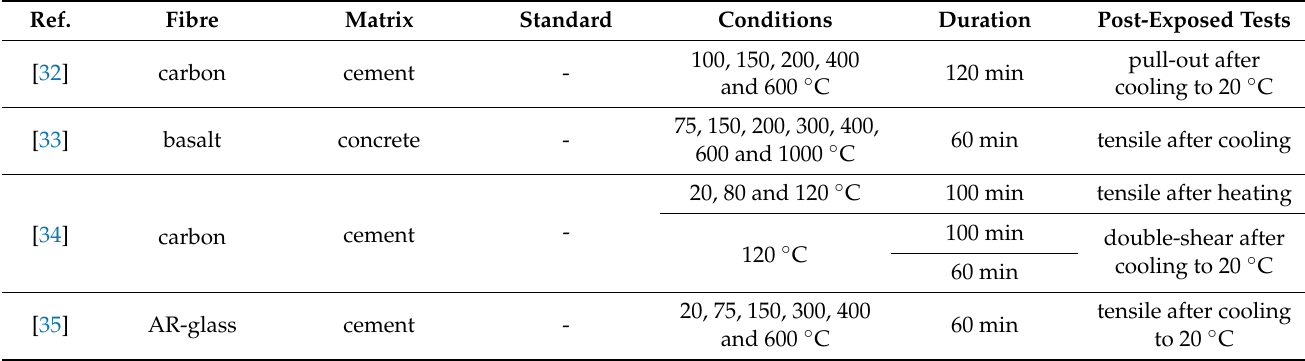
Table 4. Summary of literature on effect of elevated temperatures.